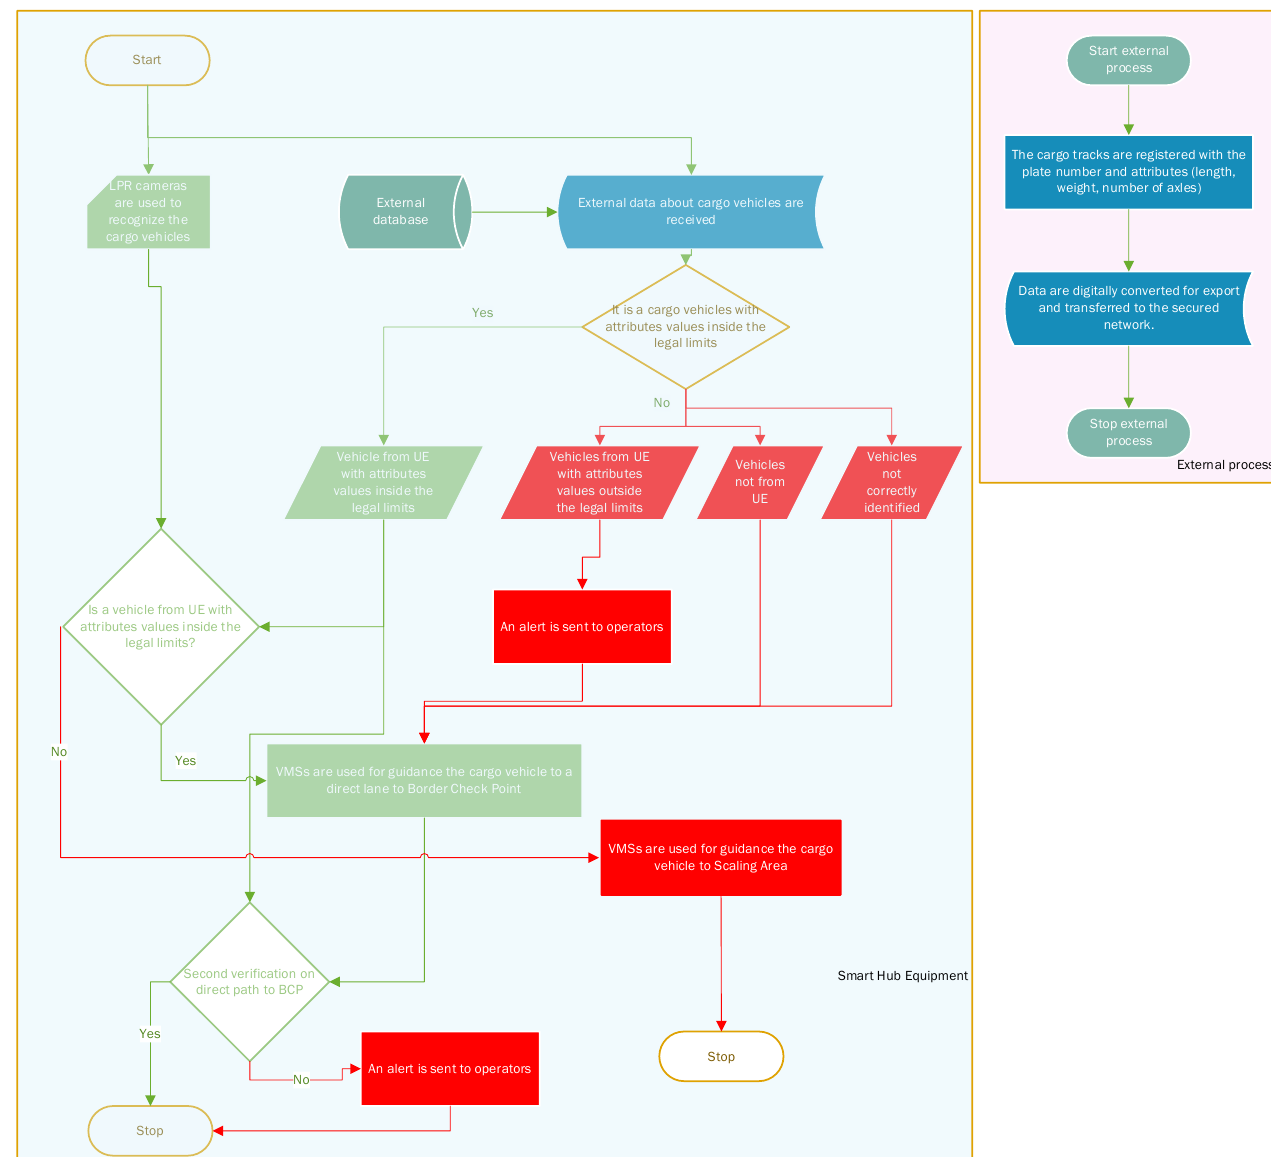
Figure 3. The logical model for checking vehicle attributes. For the actual situation, the scaling process for all cargo vehicles leads to a large queue with waiting time over 48 h in peak traffic periods. Splitting the vehicle flow onto two paths has a positive impact. Considering the scaling process and documents verifica- tions as processes in the queuing system, the increase of the number of service stations leads to the reduction of waiting times. The proposed configuration is presented in Figure 4.